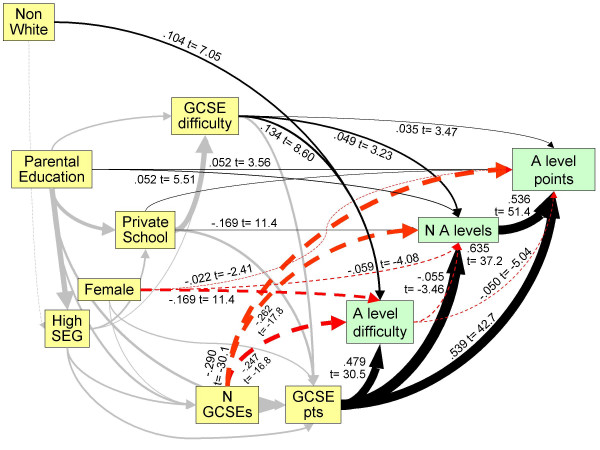
Path model of influences of background factors and GCSE performance (variables in yellow), upon A-level difficulty, number of A levels taken, and A-level performance (variables in pale green). Path coefficients and t-statistics are shown alongside paths, the thickness of paths is proportional to the path coefficient, and negative paths are shown as red, dashed lines. Paths previously shown in figure 2 are in pale grey without coefficients, to avoid undue confusion.